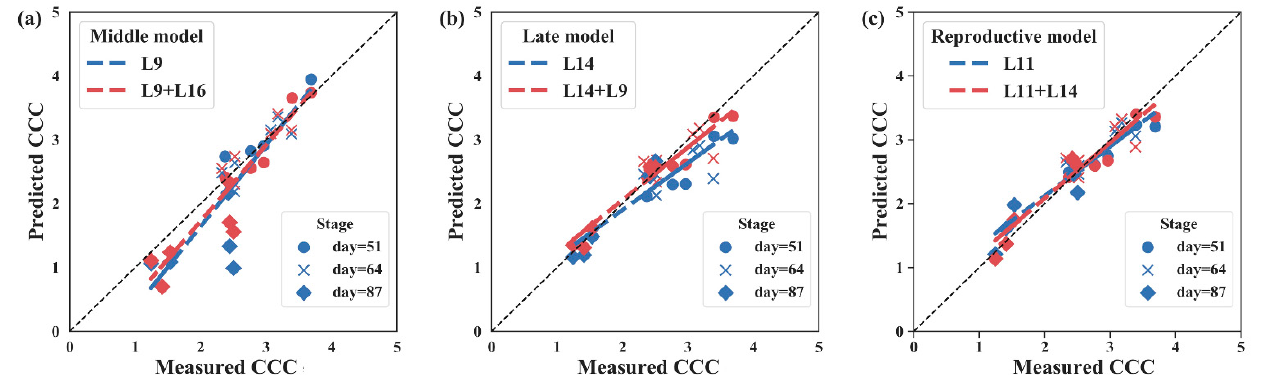
Figure 6. The canopy chlorophyll content (CCC) predicted by the middle model ( a ), late model ( b ), and reproductive model ( c ) compared to measured CCC in 2019. LCC was predicted from mRER, which had the highest accuracy of chlorophyll inversion in this study. The blue dotted line indicates predicted CCC from LCC of one leaf position, and the red line indicates predicted CCC from LCC of two leaf positions. The 2019 dataset included three growth stages: the sixteen-leaf stage (day 51,